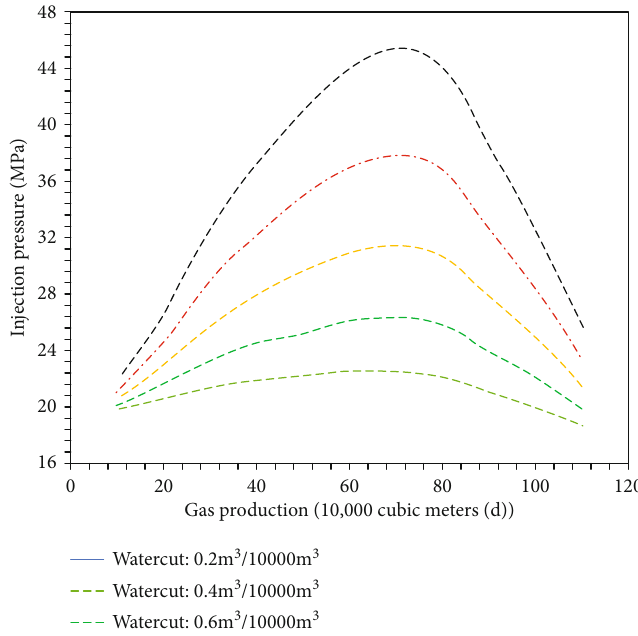
Figure 10: Methanol injection pressure